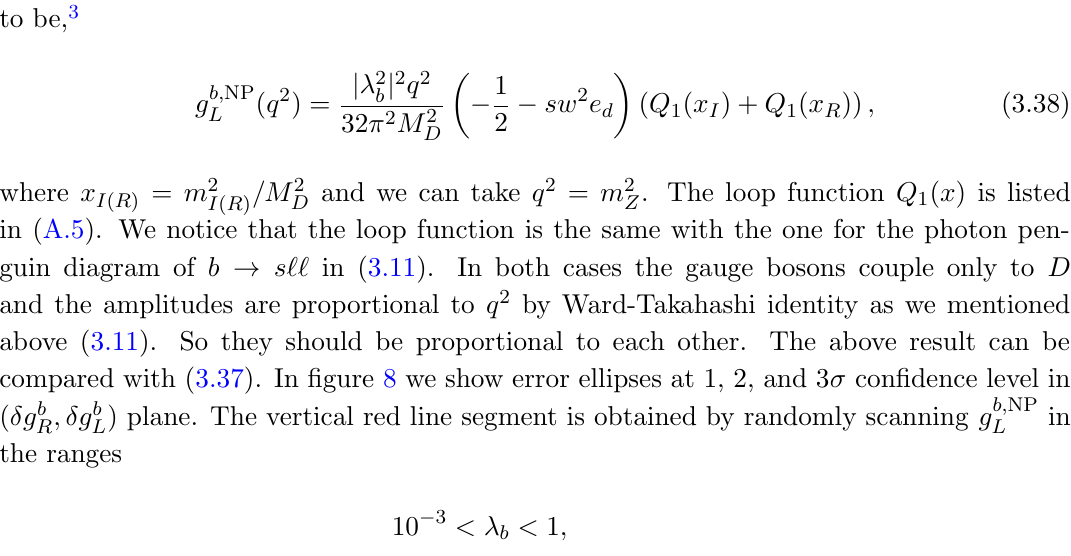
Figure 8 . The error ellipses at 1, 2, and 3 (cid:27) con(cid:12)dence level (from inside) in ( (cid:14)g b thick red line segment represents the model